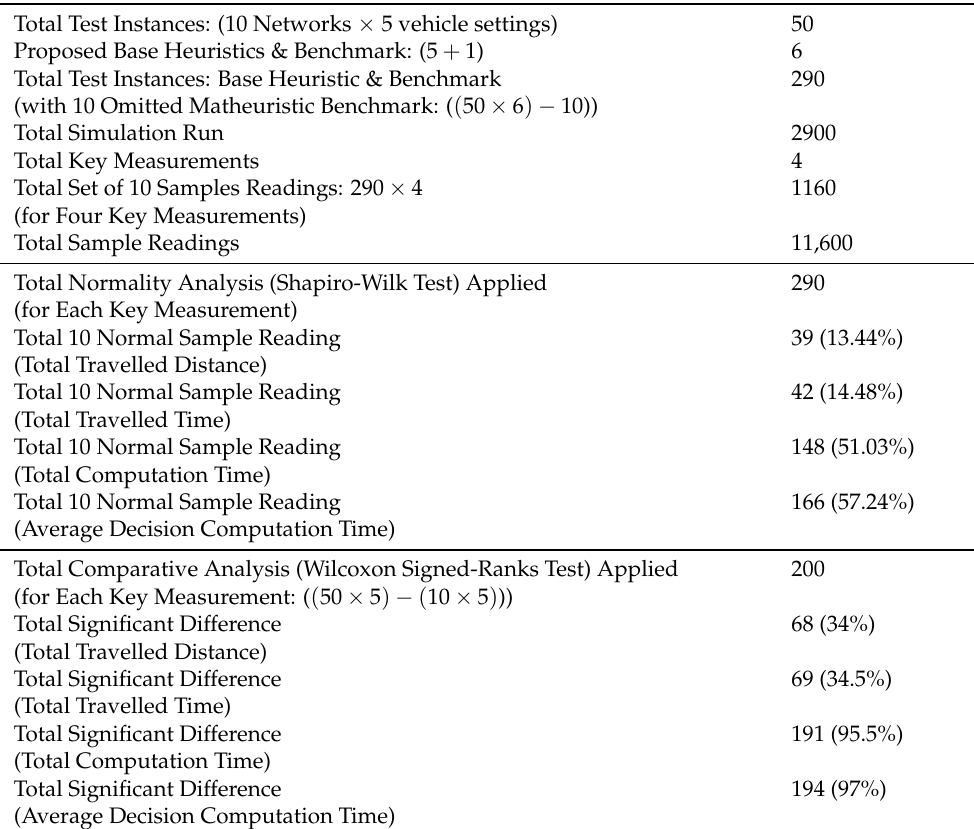
Table A1. Descriptive overall view on simulated data collected.